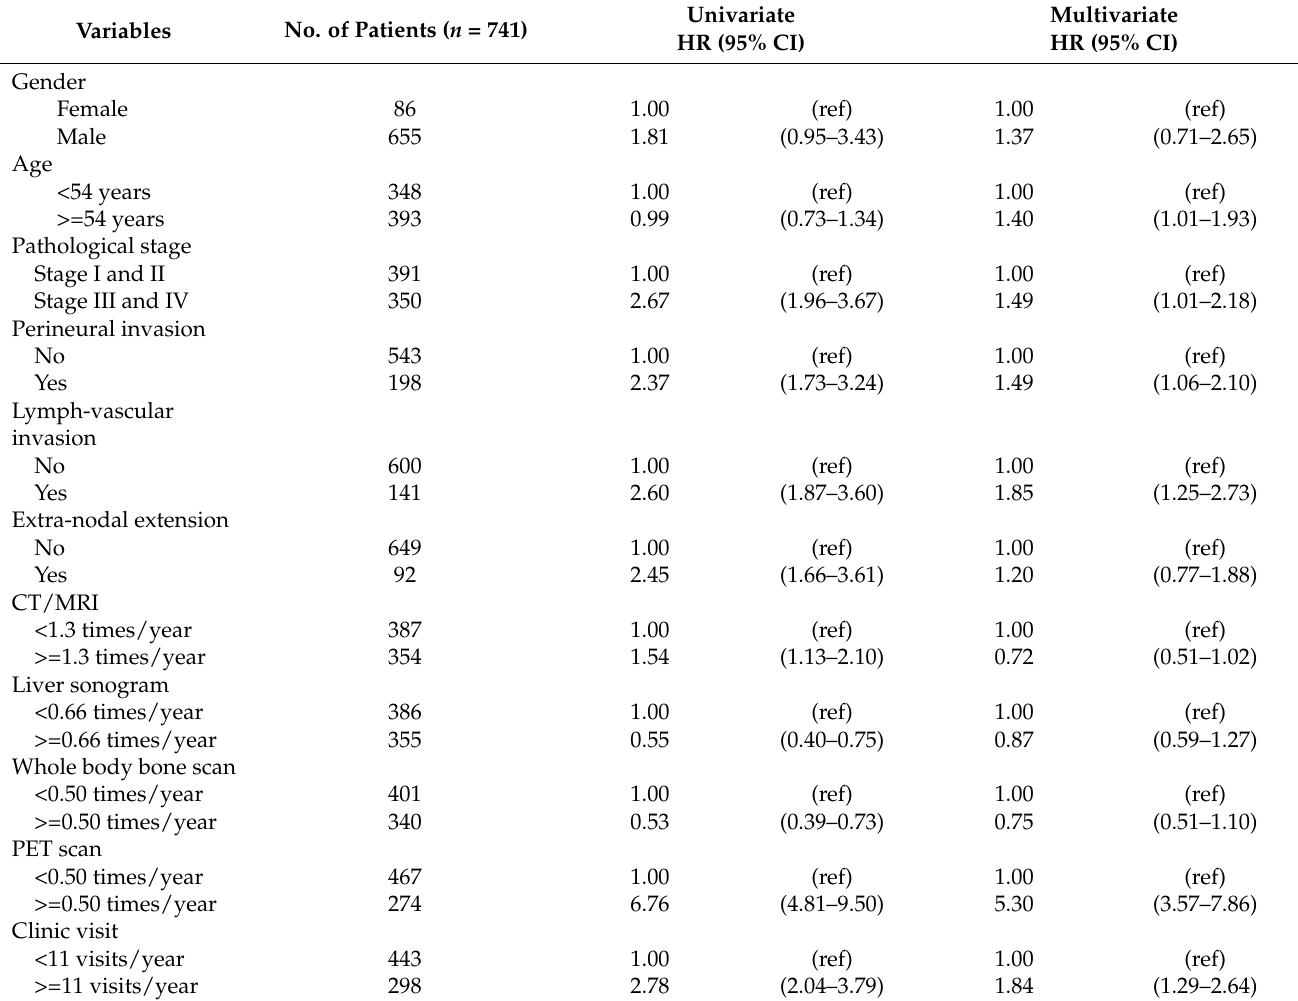
Table 3. Factors associated with disease-specific survival in oral cavity cancer